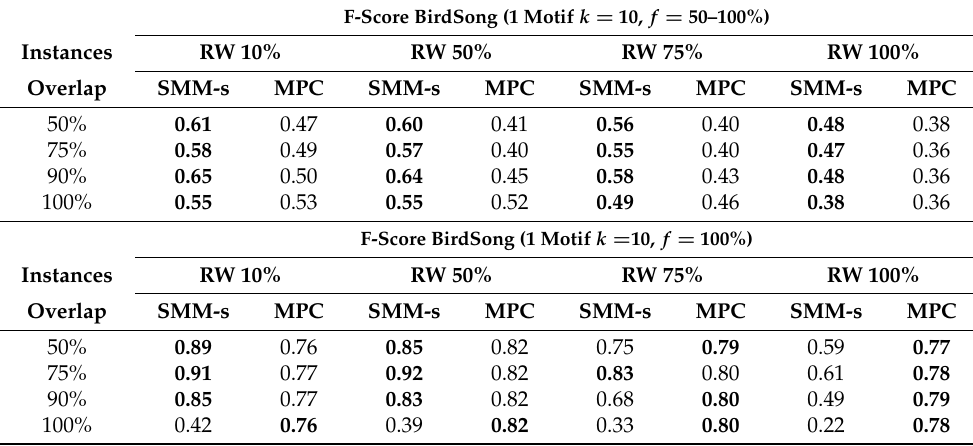
Table 8. F-scores for time series with recurring patterns that are not variate-aligned from BirdSong. F-Score BirdSong (1 Motif k = 10, f =